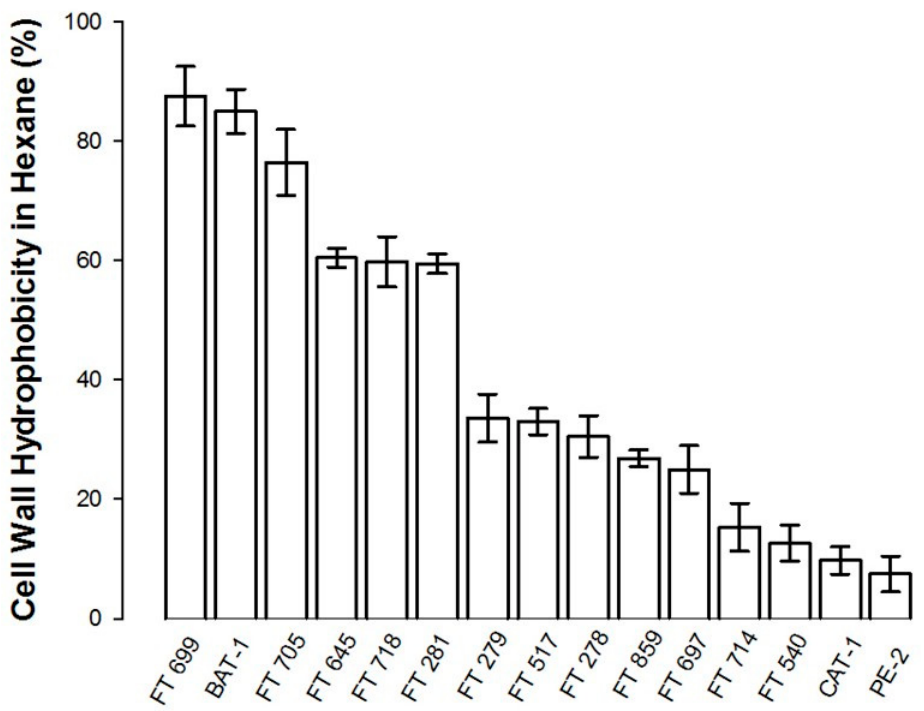
Figure 4. Cellular hydrophobicity of the analyzed industrial fuel-ethanol yeast strains. The hydrophobicity of the cells suspended in water was quantified by means of a biphasic partitioning assay using hexane as hydrophobic solvent.